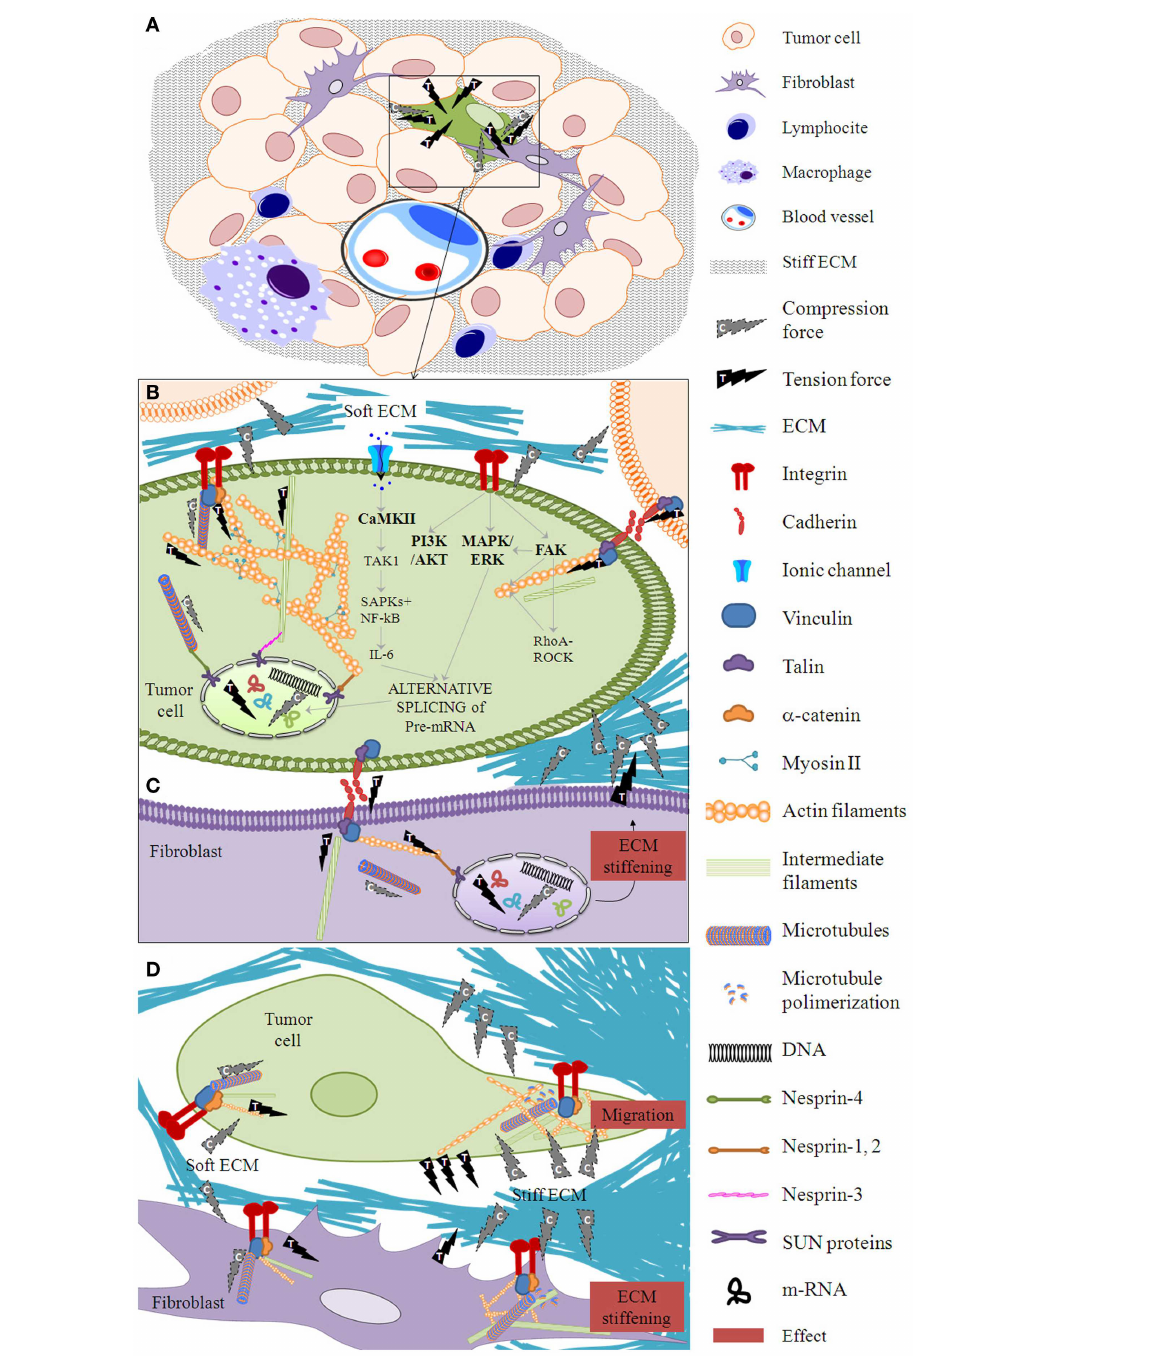
FIGURE 1 | Mechanotransduction phases . (A) When forces are exerted on a tissue after proliferation of tumor and stroma cells, a cell within the cell mass (for example, the one marked in green) is subject to mechanical deformation in a phase called mechanocoupling. Following the principle of tensegrity at the tissue level, ECM elements apply compression forces to the tissue cells and tissue cells exert tension forces between themselves and to the ECM. Biotensegral elements of the boxed area are detailed in (B–D) . (B) This particular tumor cell activates a biochemical coupling phase in which the mechanical signal is transformed into intra-cellular biochemical signals through the integrin–cytoskeleton–nuclear matrix structure or stretch-activated cation channels within the cell membrane, among other